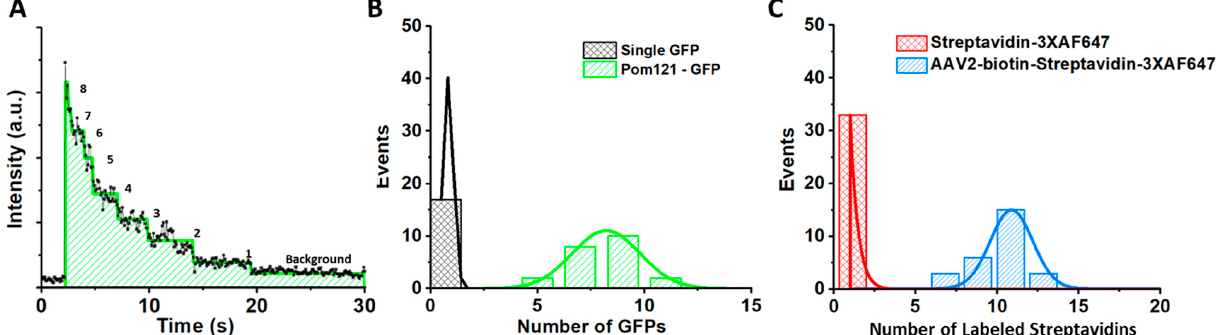
Figure 6. Copy number of GFP-fused NPC and labeling efficiency of Alexa Fluor 647–AAV2 molecules. ( A ) Photobleaching curve of a single GFP-labeled NPC [61]. The steps were determined by the maximum likelihood ratio method. The intensity of single GFP was determined by averaging the step intensity of GFP-POM121 in the NPC of live cells. ( B ) A comparison of the fluorescence intensities from single GFPs to ~8 copies of POM121-GFP found in each NPC [61]. ( C ) A comparison of the fluorescence intensities from single streptavidins with three bounded Alexa Fluor 647 dyes to ~12 copies of 3X Alexa Fluor 647-labeled streptavidin bound to single biotin-labeled AAV2 particles [33].